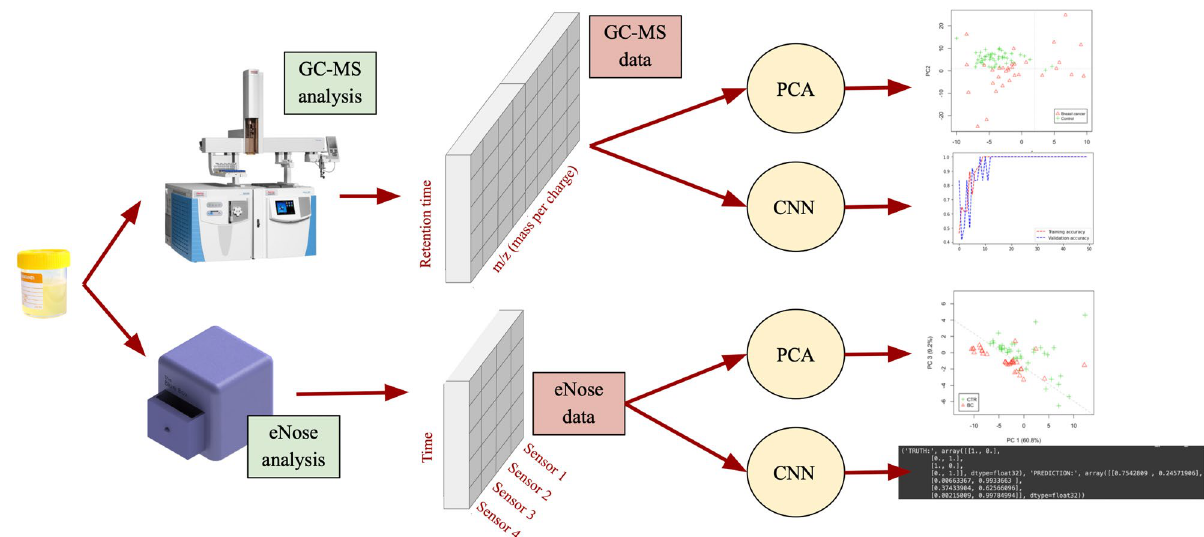
Figure 2. Design of the project. Upon collection, urine samples were analyzed using both an eNose and a GC– MS. Data resulting from the GC–MS analysis contain information relative to the m/z of the VOCs found in the sample per unit of time (retention time). The output of the eNose analysis was a 2D array that was informative of the intensity of each sensors’ reaction as a function of time. Finally, both datasets were input to a biostatistics- based classification (PCA) as well as an AI-based classification